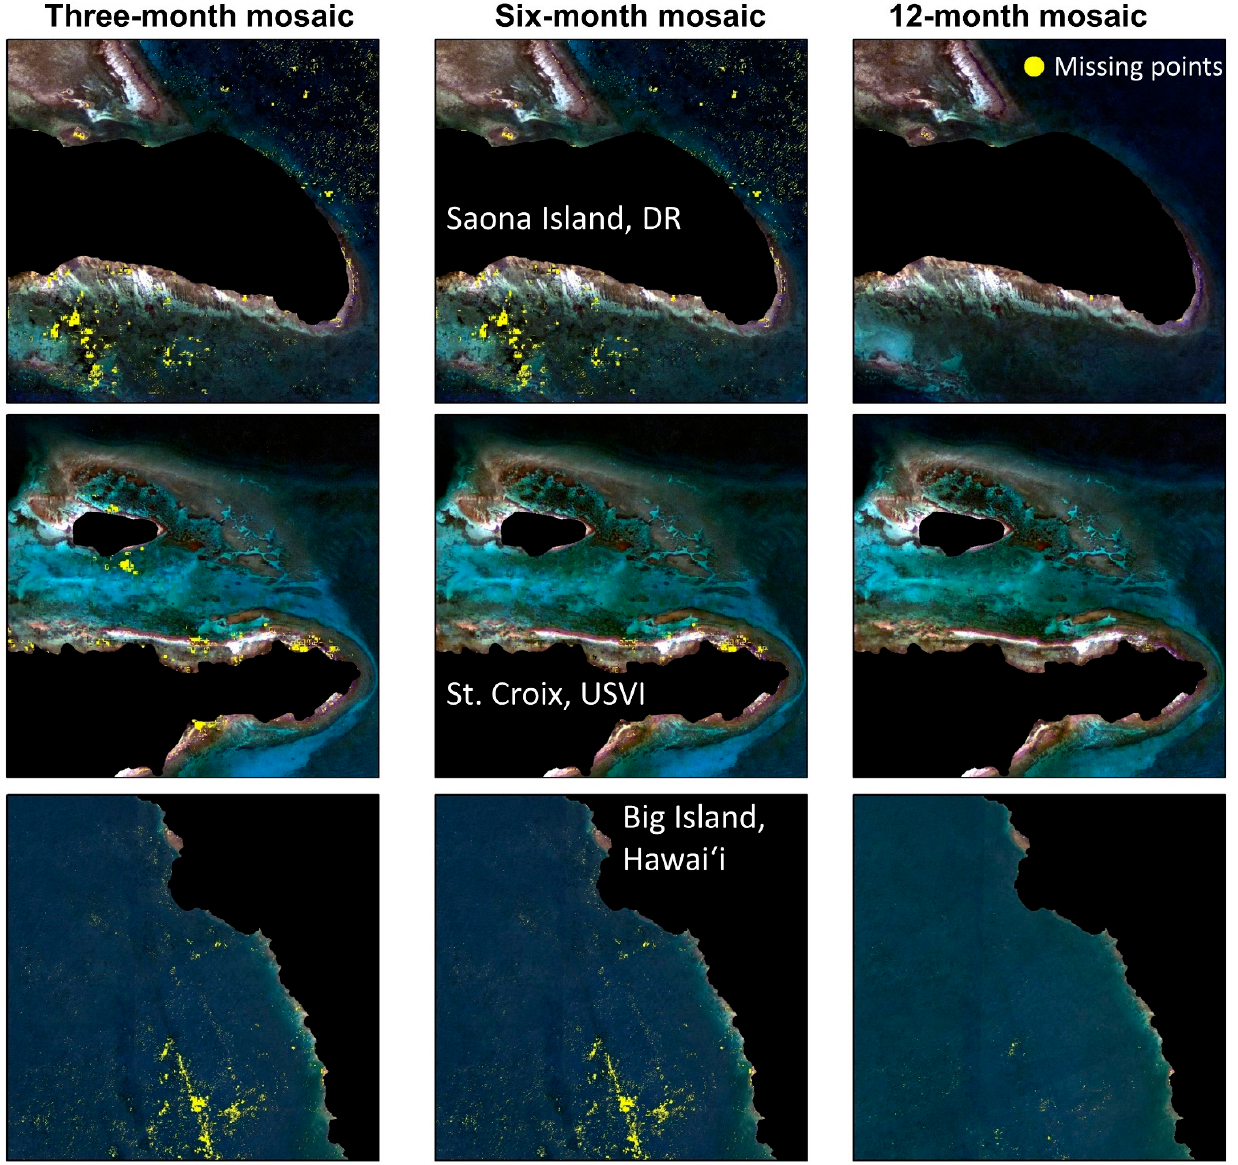
Figure 3. Comparison of the surface reflectance mosaics created using different time ranges. The yellow color represents missing points where no reflectance pixels were selected in the time range to build the mosaic.